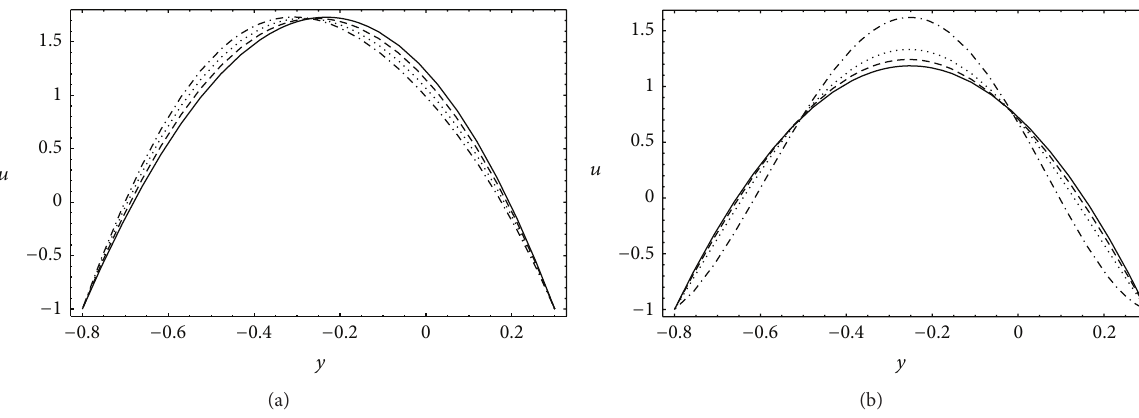
Figure 5: Axial velocity 𝑢 for 𝑎 = 0.7 , 𝑏 = 1.2 , 𝑑 = 2 , 𝜙 = 0 , 𝑏 𝑠 = 0.01 , 𝑛 = 2 , 𝑥 = 𝜋 : (a) 𝑁 = 5 , 𝜃 = 2.2 ,